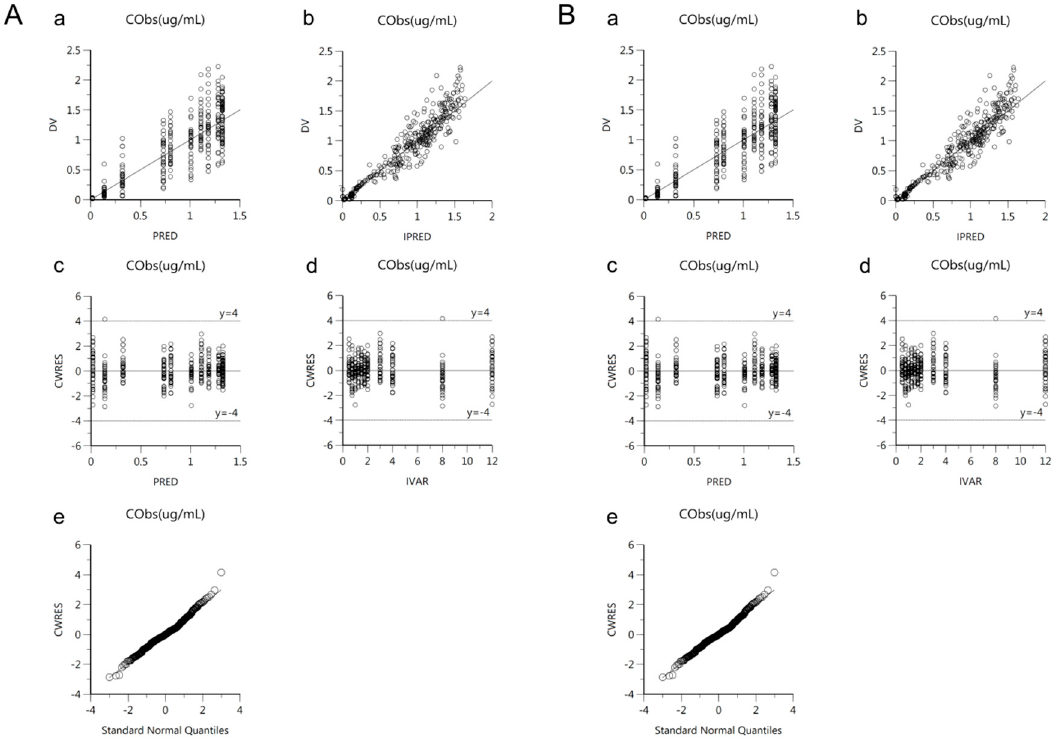
Figure 3. Goodness-of-fit plots of base model ( A ) and final model ( B ) for trans -cefprozil. ( a ) Observed plasma concentrations (DV) against population predicted concentrations (PRED); ( b ) Observed plasma concentrations (DV) against individual predicted concentrations (IPRED); ( c ) Conditional weighted residuals (CWRES) against population predicted concentration (PRED); ( d ) Conditional weighted residuals (CWRES) against time (IVAR); ( e ) Quantile-quantile plot of components of conditional weighted residuals. Table 5. Population pharmacokinetic parameter estimates for cefprozil and bootstrap validation.